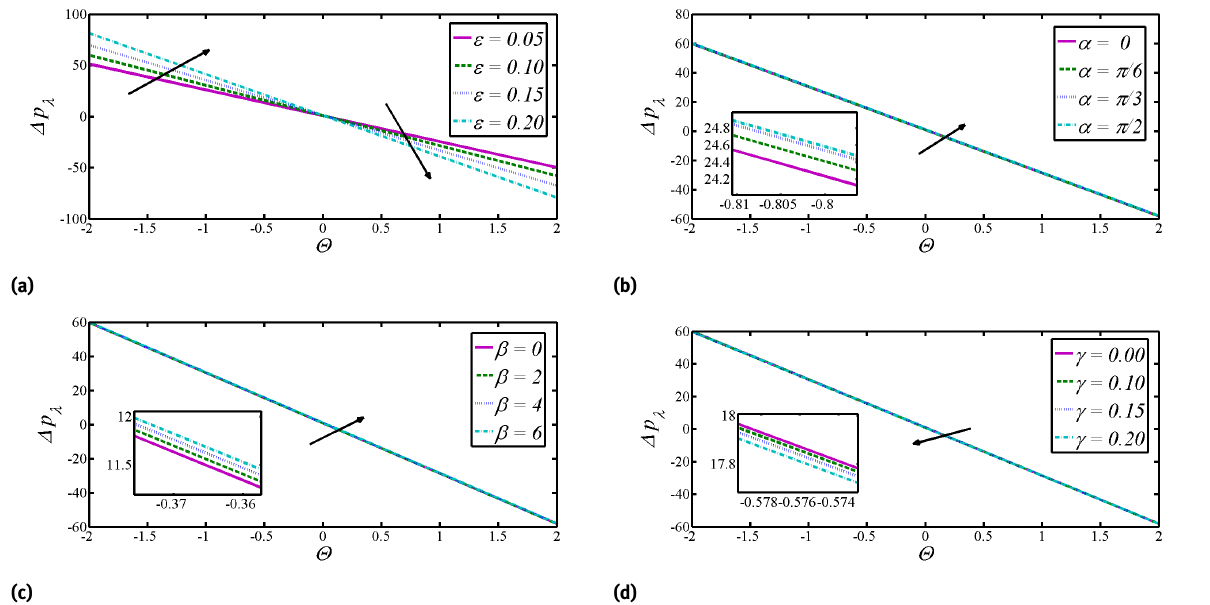
Fig. 5: The pressure difference verses volume flow rate for various fluid parameters.